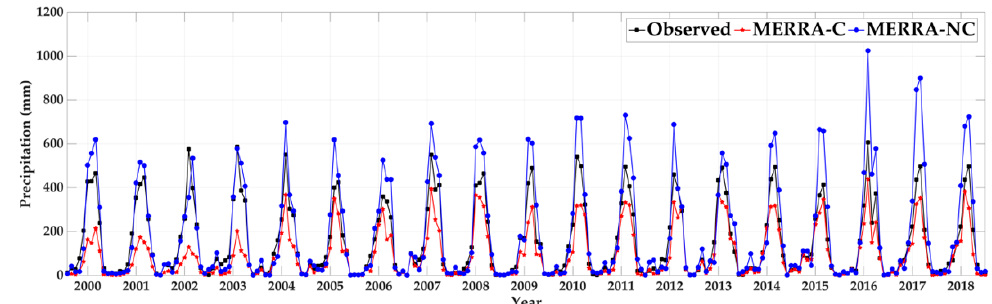
Figure 2. Monthly precipitation time-series (mm) from observed, MERRA-C, MERRA-NC average over Nepal during 2000–2018.